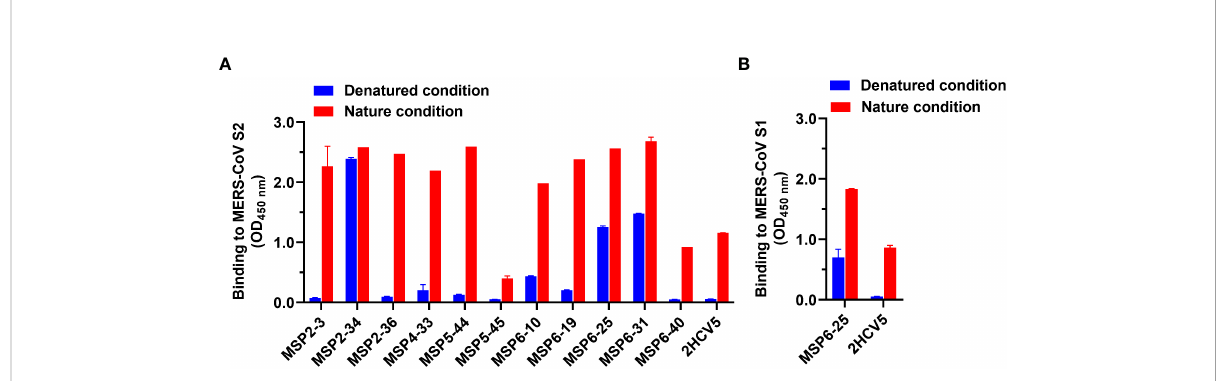
FIGURE 4 Analysis of binding epitopes of mAbs. (A) Binding of mAbs (1 m g/ml) to MERS-CoV S2 in non-treated nature condition and heat-denatured condition (37°C, 1 h, in the presence of SDS and DTT, blue). An unrelated conformational anti-HCV mAb 2HCV5 was used as a control, to which the coating antigen was HCV E2 protein. (B) Binding of antibody MSP6-25 (1 m g/ml) to MERS-CoV S1 in nature condition and in heat-denatured condition in the presence of SDS and DTT (blue). Data were analyzed and plotted by GraphPad Prism (version